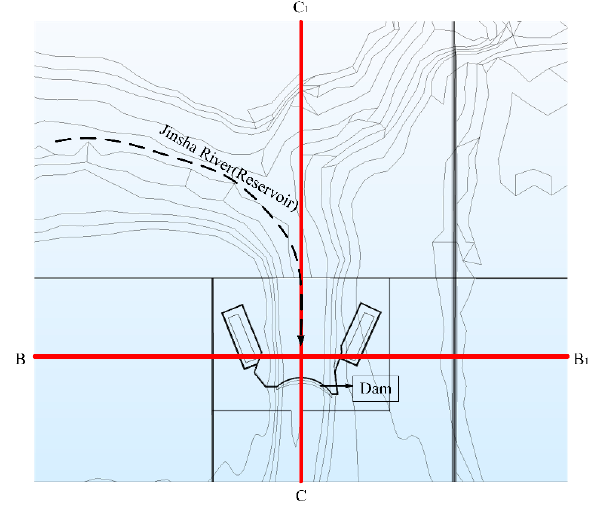
Figure 13. 2D sections used for displaying the simulation result (B–B1: Transversal section, C–C1: Longitudinal section). Longitudinal